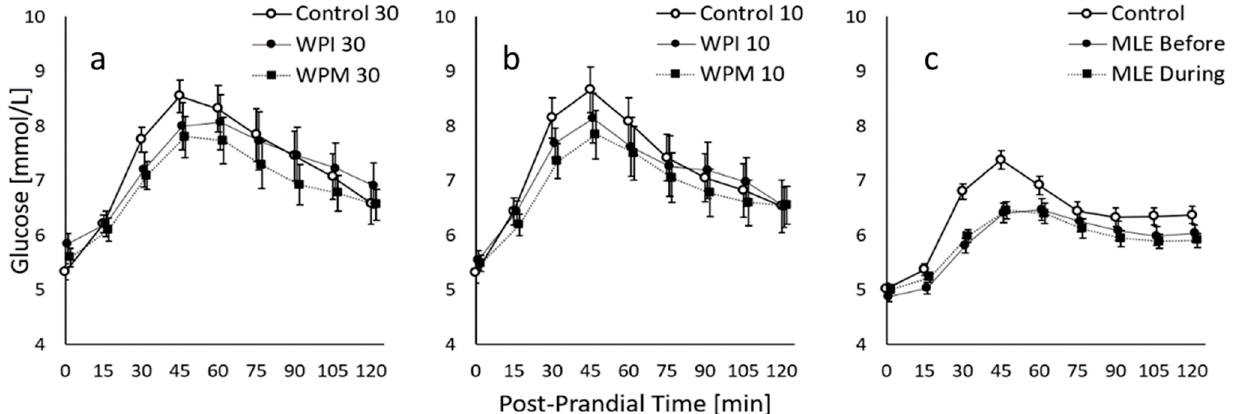
Figure 2. Average 2h-PPGR of the protein premeal study featuring n = 14 completers, with premeal taken either 30 min before ( a ) or 10 min before ( b ) the complete breakfast with an estimated GL of 48 g, and average 2h-PPGR of the MLE study featuring n = 30 subjects ( c ). The figure shows cross-sectional values with mean ± SE.